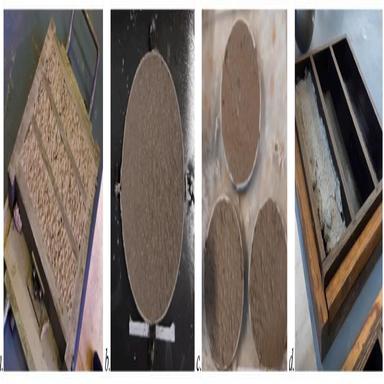
Moulds used for (a) prism, (b) disk, (c) small disk and (d) tile samples.